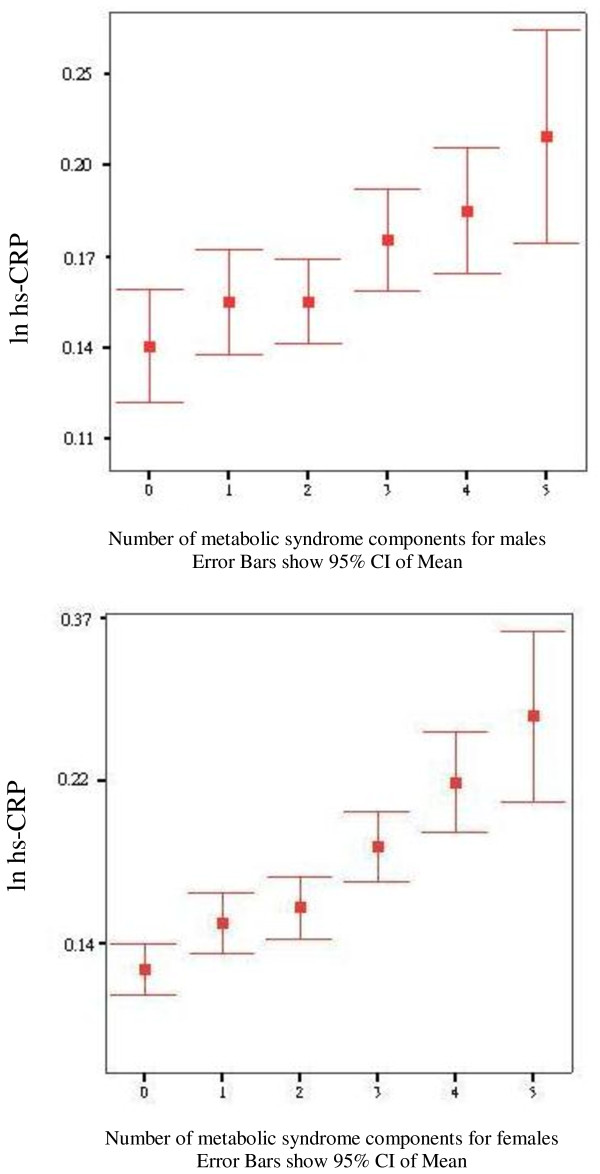
Figure 1 Geometric means of Hs-CRP and 95% CI according to the number of abnormal components of the metabolic syndrome, defined by criteria of the American Heart Association/National Heart, Lung, and Blood Institute (AHA/NHLBI) according to gender.